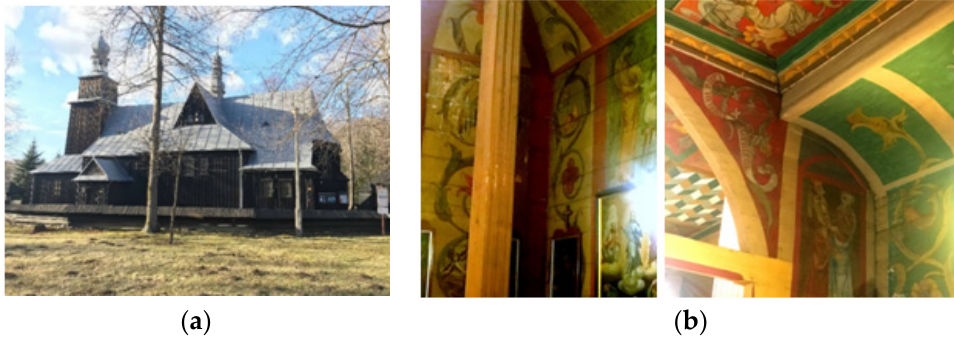
Figure 1. South elevation of the church ( a ) and wall paintings ( b ).